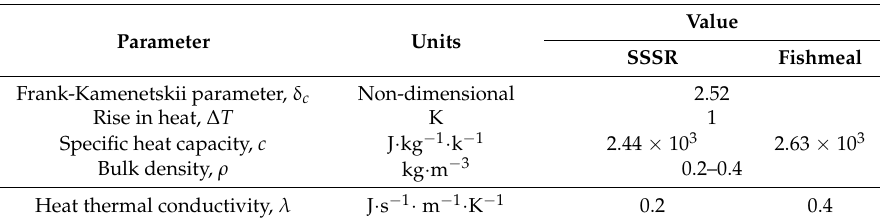
Table 10. SSSR and fishmeal